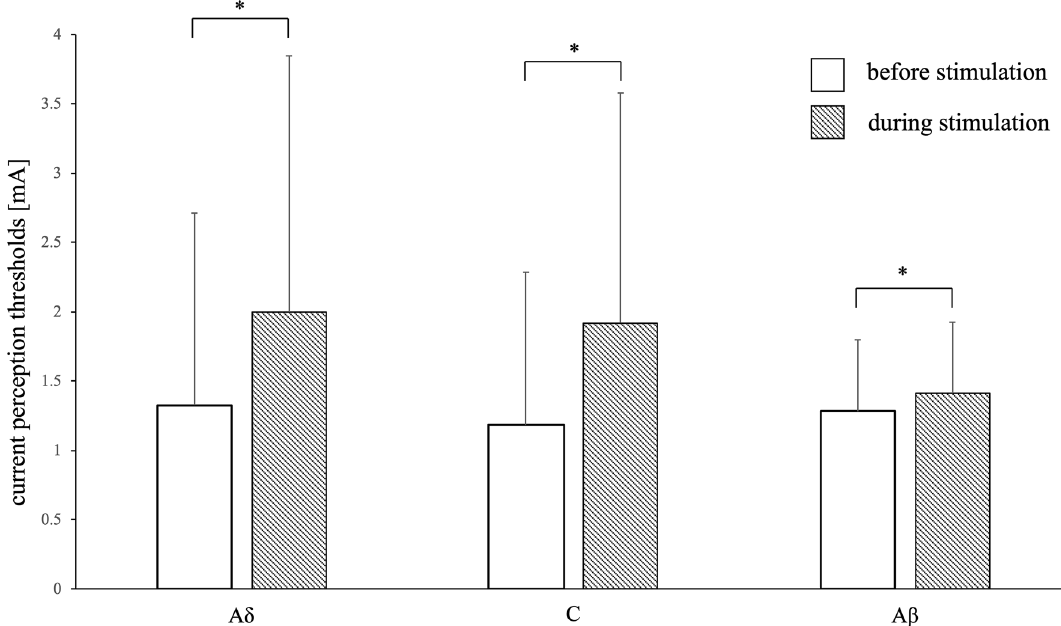
Figure 2. Current perception thresholds under noxious condition. Differences in the mean value of current perception thresholds before and after noxious stimulation. The error bars indicate standard deviation. Significant increases are observed in the current perception threshold of the Aδ, C, and Aβ fibers after hand immersion in cold water. Asterisks represent significant differences (* P < in pain threshold was observed in either the Aδ or C fibers, despite light stimulation through rubbing with a brush. Moreover, as mentioned above, the changes in the sensory thresholds of the Aβ fibers were minor and of little physiological or clinical significance. The following two factors might have influenced the results of this study. First, the pain threshold obtained through current stimulation was used as an index of pain inhibition rather than subjective pain intensity; second, stimulation through light rubbing with a brush was chosen as the non-nociceptive stimulation method. The pain threshold was defined as the current intensity at which the par- ticipant first became aware of the stimuli when the current intensity of the Aδ or C fibers gradually increased. Therefore, the subjective pain intensity in this study was extremely low, and there might have been a discrepancy in the findings due to touch-induced analgesia experienced in daily life. Previous studies 14,16,17 have evaluated changes in subjective pain intensity as an index of pain inhibition through light tactile stimulation. Addition- ally, the gate-control theory has been used to define the mechanism of pain inhibition through non-noxious stimulation, such as tactile stimulation of the body surface. According to the gate-control theory, the thick fibers activate inhibitory interneurons in layer II of the dorsal horn of the spinal cord, called the substantia gelatinosa, and inhibit the transmission of nociceptive information by the thin fibers. In this study, a light-rubbing stimulus with a brush was used. Pleasant tactile stimuli, such as the one mentioned above, are generally transmitted not only by Aβ fibers but also by C fibers, which transmit tactile sensations 17–19 . As per the gate-control theory, the thin nerve fibers that transmit nociceptive information suppress inhibitory interneurons in the dorsal horn of the spinal cord; that is, they have the effect of opening the gate. Although the light rubbing stimulus used in this study was a tactile stimulus, it acted on opening the gate by inhibiting the inhibitory interneurons in the dorsal horn of the spinal cord through the transmission of stimulus information by the thin C fibers, which might have prevented the expected gate-control effect on pain. In contrast, the nociceptive stimulus provided through immersing the hand in cold water increased the pain threshold of both the Aδ and C fibers. This change in the pain threshold of the Aδ and C fibers can be regarded as a sufficient amount of change compared to those observed in previous studies 12–14 . In contrast, the change in the perceptual threshold of the Aβ fibers in this study was not significant or sufficient, as described above. Our results indicate that noxious stimulation of the body surface inhibits relay of nociceptive information in other parts of the body. The inhibition is limited to input of nociceptive information from the Aδ and C fibers and does not affect information from the Aβ fibers. These results suggest that nociceptive stimuli may selectively inhibit pain. Pain inhibition by noxious stimulation, such as immersion in cold water, is also considered a distraction from other somatosensory information since noxious stimulation serves as critical warning signals. This corresponds with the findings of a previous study 6 that the DNIC/CPM, in which pain is inhibited by noxious stimulation of other parts of the body, reflects the function of the descending pain modulatory system, suggesting that noxious stimulation of the body surface triggers the central pain control mechanism. In this study, we investigated the pain-inhibitory response to somatosensory stimulation of the body surface through QST using current stimuli applied to different peripheral nerve fibers. Current stimuli have the advan- tages of easy control, such as changing the stimuli intensity or switching it on/off, high reproducibility, and the